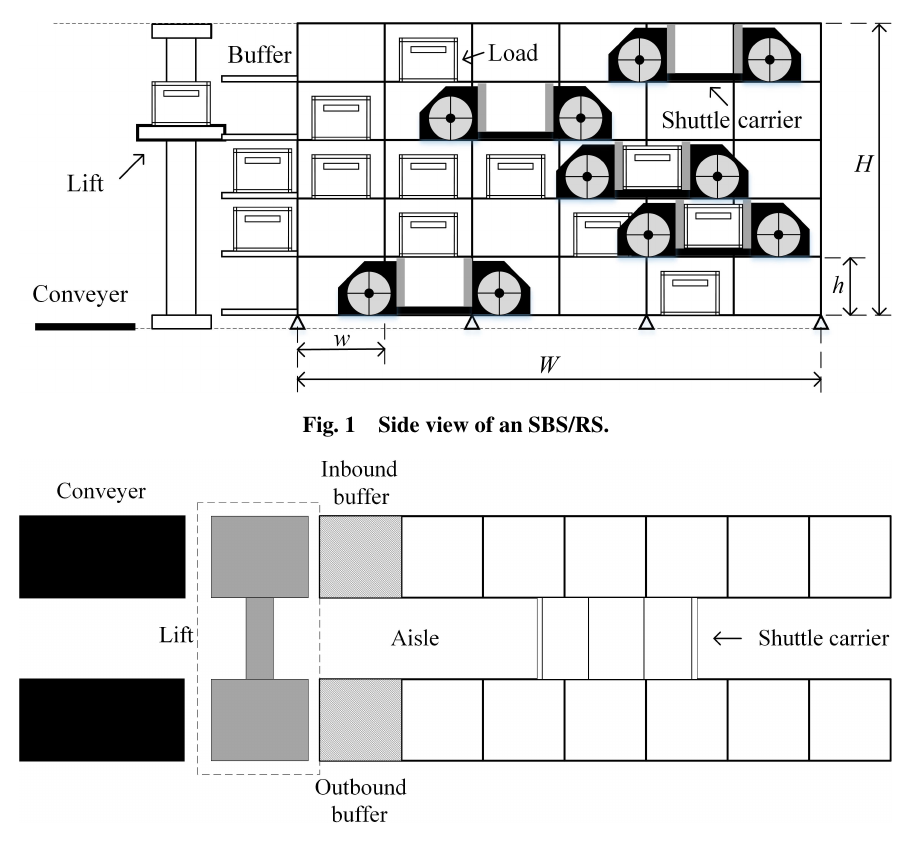
Fig. 2 Top view of an